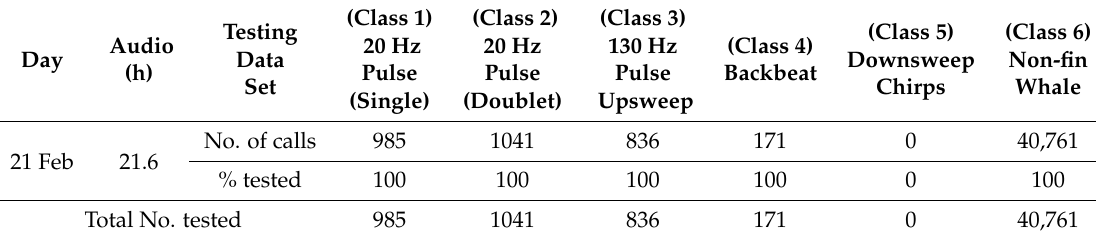
Total No. trained Table 3. Test data set was extracted from a subset of POAWRS detections within the 10 to 200 Hz frequency range and observed off the coast of Alesund, Norway on 21 February 2014. It should be noted that the total number of non-fin whale (Class 6) detections is significantly larger when going up to the 4 kHz frequency range since this data set is only a subset of the overall POAWRS detections on 21 February